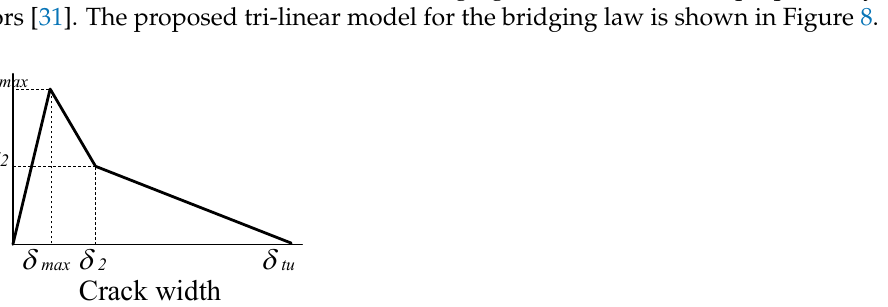
Figure 8. Tri-linear model for bridging law of PVA-FRCC [31].